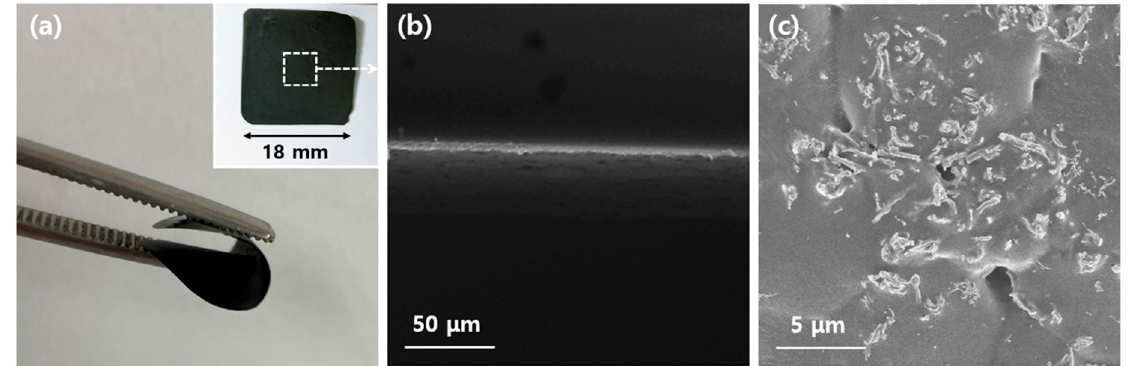
Figure 6. Imaging of the PEDOT:PSS-coated Ag 2 Se NW/PEDOT:PSS composite films: ( a ) digital photograph showing the bendable property; ( b , c ) FE-SEM images.